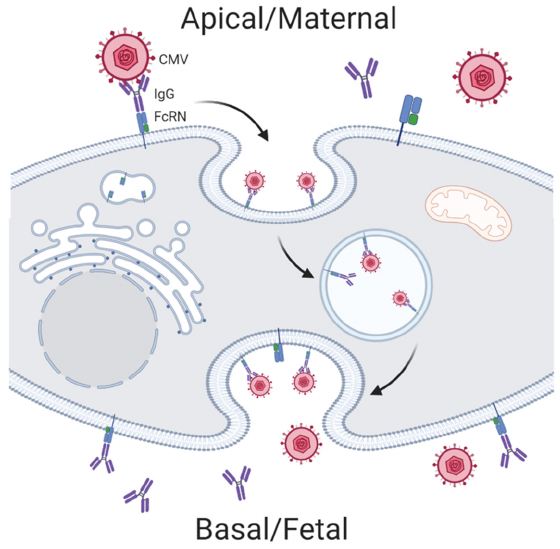
Figure 3. Antibody-dependent enhancement mechanisms hijacked by cytomegalovirus (CMV) for mother to child transmission. Created with BioRender.com. mother to child transmission. Created with